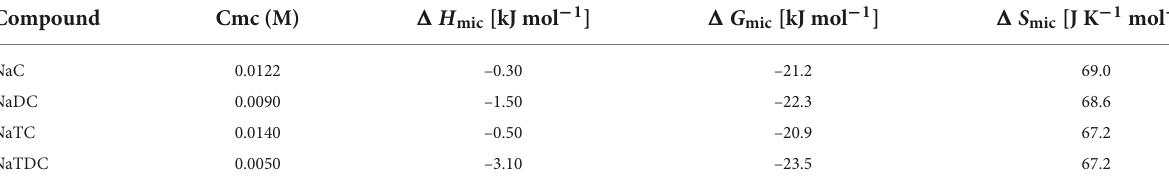
TABLE 2 Cmc and thermodynamic parameters for micelle formation, obtained from ITC experiments, for the bile salts under study at 303.16 ◦